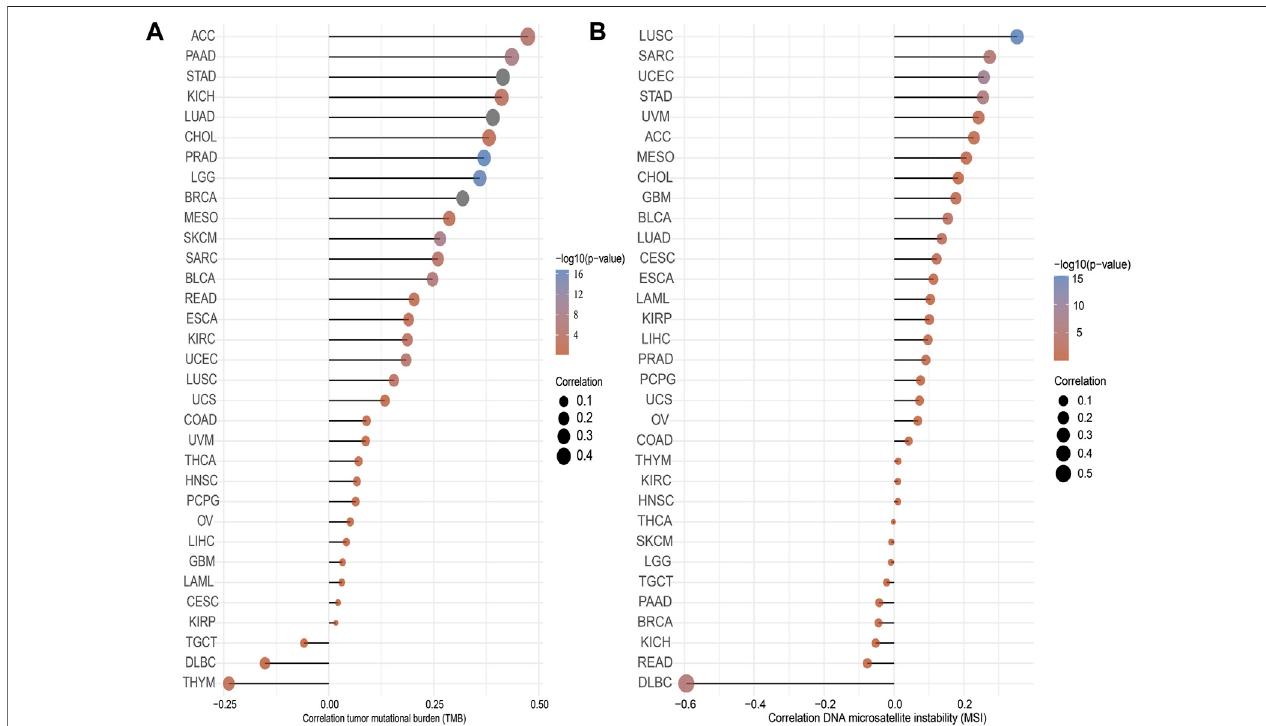
FIGURE5| AnalysisofthecorrelationbetweentheIQGAP3andTMS,MSI. (A) AnalysisofthecorrelationbetweenIQGAP3andTMS. (B) Analysisofthecorrelation between IQGAP3 and MSI.